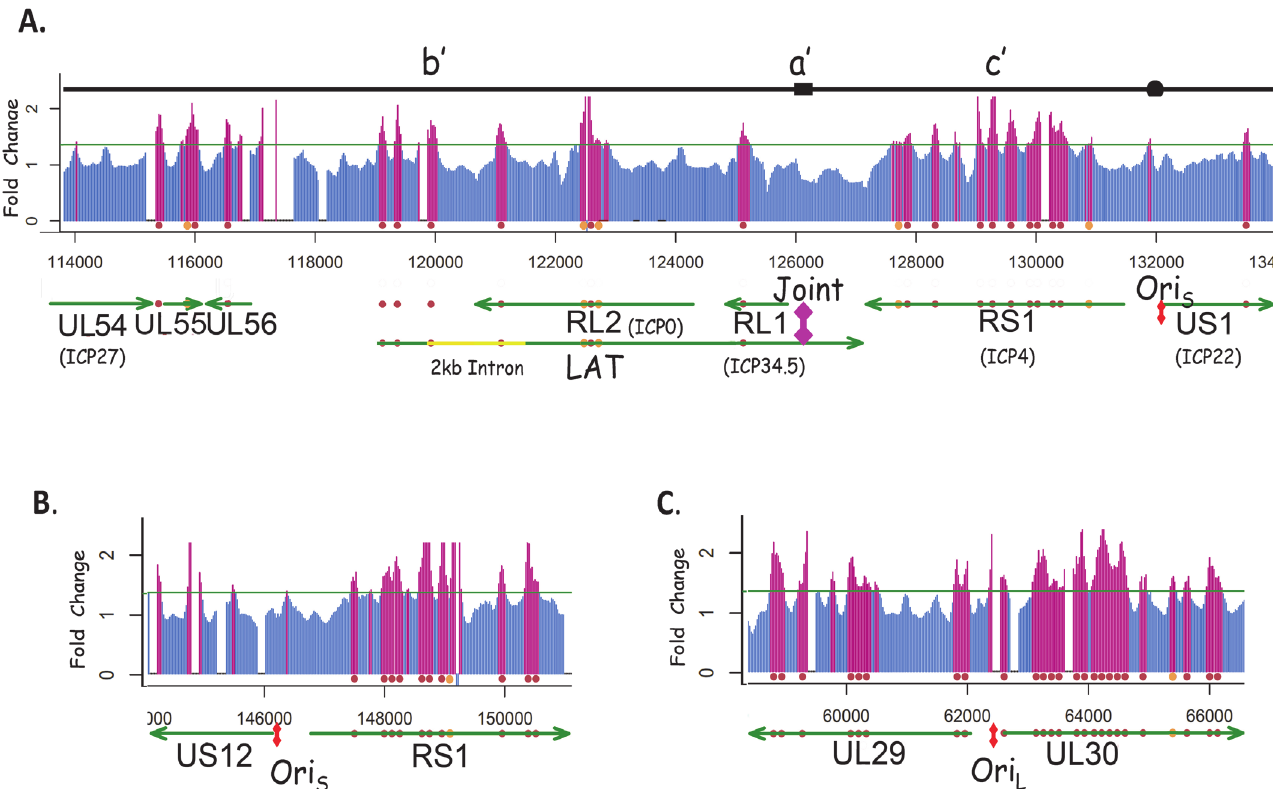
Fig 8. The “ joint ” and “ Ori ” regions are low in nucleosomes. A . The black line maps the b ’ , a ’ and c ’ repeat regions of the viral genome surrounding the “ Joint ” of the Long and Short segments. The hybridization signal to array oligos is shown as blue lines below and red for above our fold change cut off. Spaces in the blue and red lines are “ poorly performing ” oligos. Transcripts are mapped below as green arrows, with nucleosomes presented as red or orange balls. At 6h PI the region of the genome including the “ joint ”— where the long and short segments of the HSV-1 genome isomerize — is not coated with nucleosomes. ( A .). ORI S has no nucleosomes near it ( A . and C .) whereas ORI L has some. B .